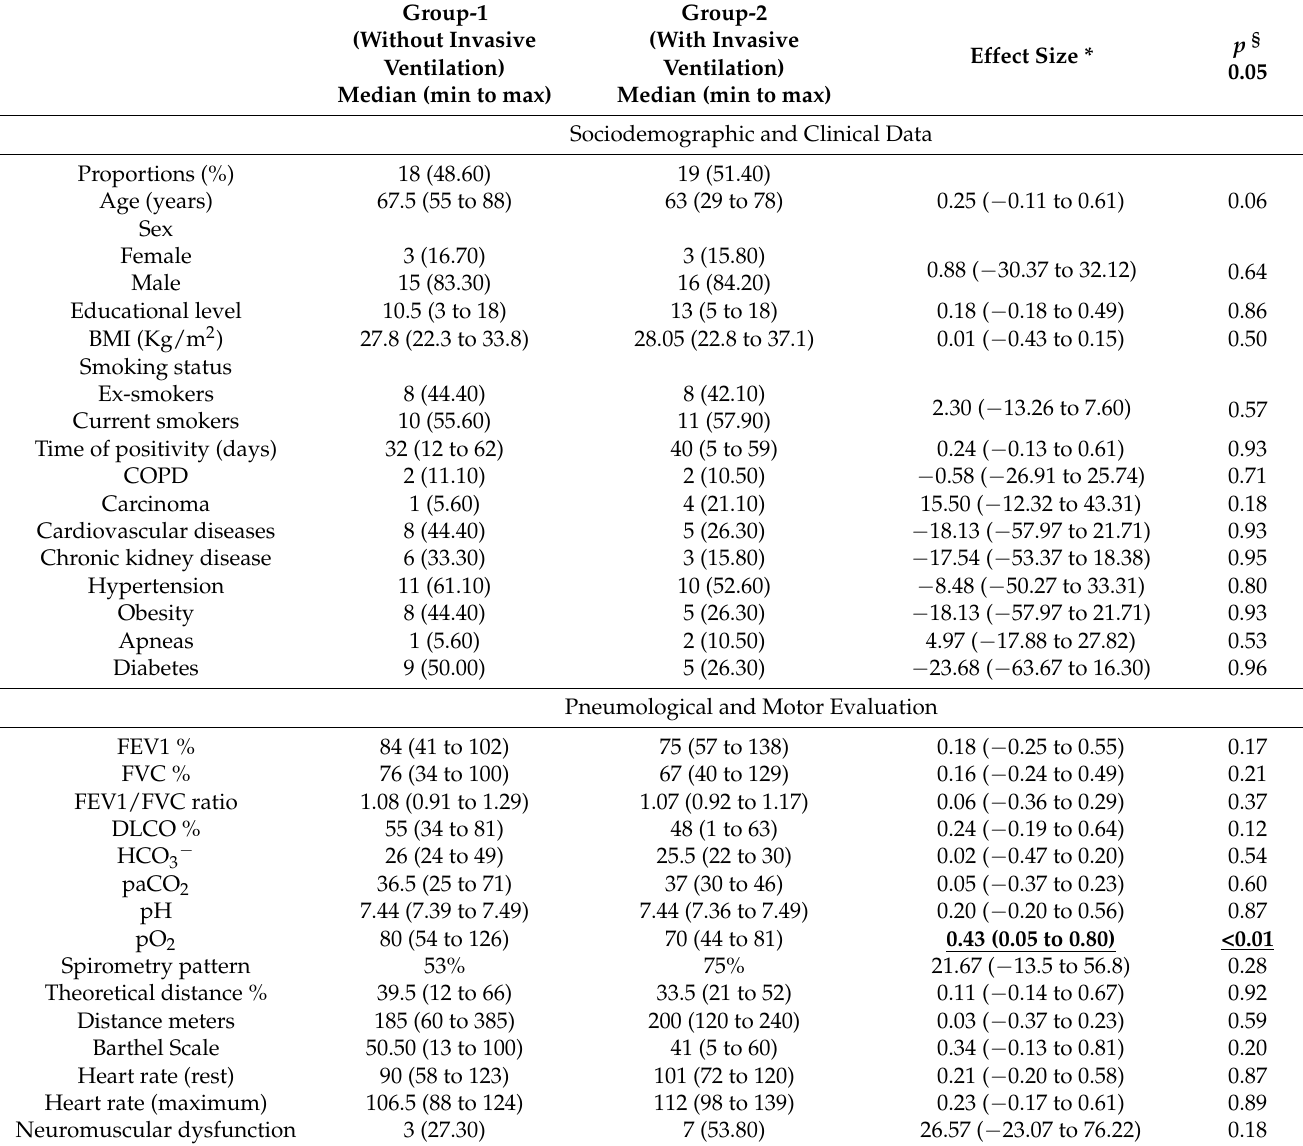
Table 1. Description of the whole sample according to the type of respiratory support ( n =